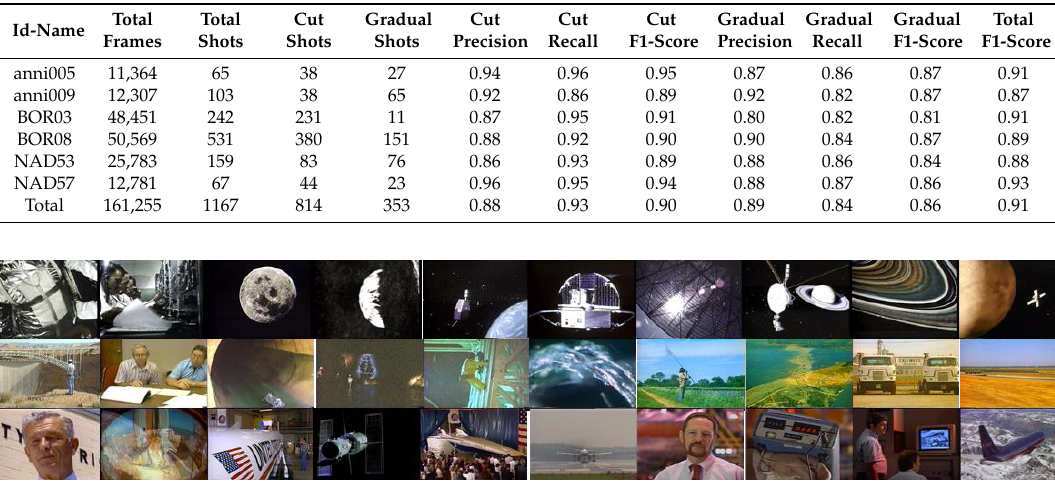
Figure 10. Samples of the frames from the test TRECVID 2001 dataset.